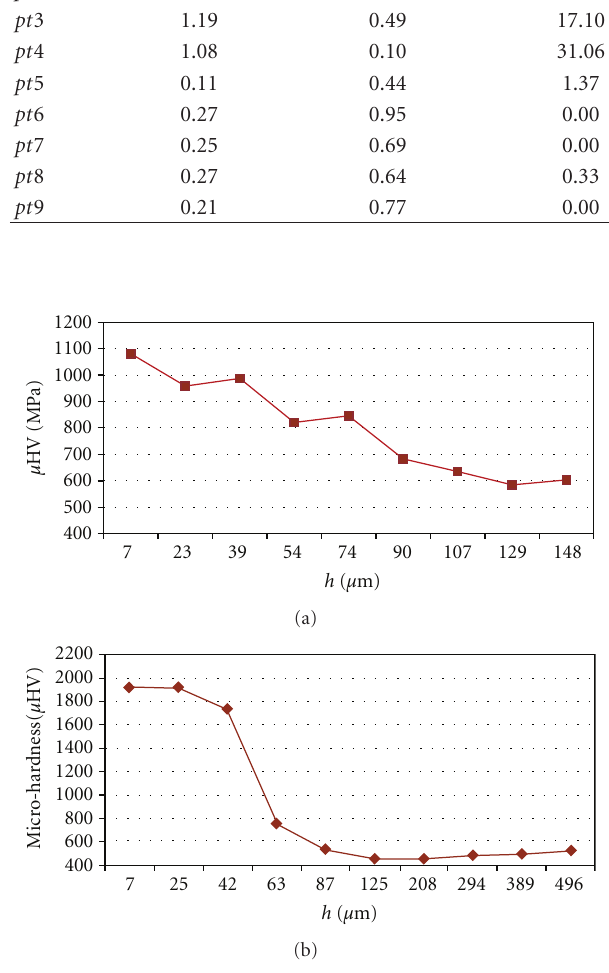
following alloying parameters: pulse amperage: 48 A, pulse duration: 1600 μ s (Table 2; Figure 11). For the electrodes with di ff erent materials like tungsten and tungsten